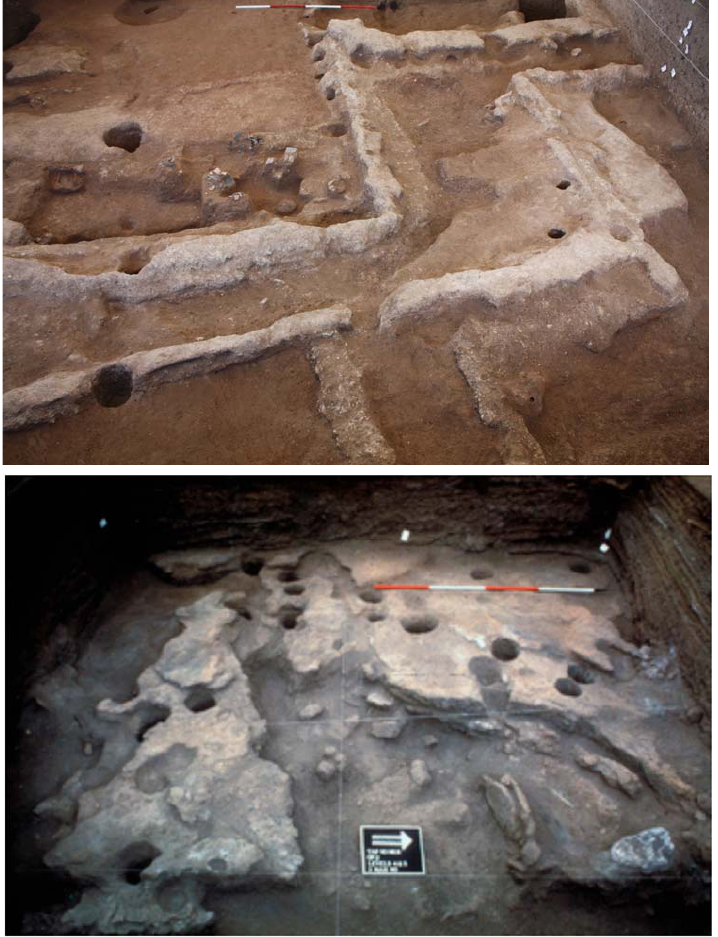
Fig. 11: Occupation areas in the Mun Valley and the Lopburi area reveal superimposed clay floors. Above, late Iron Age Non Ban Jak and below, Nil Kham